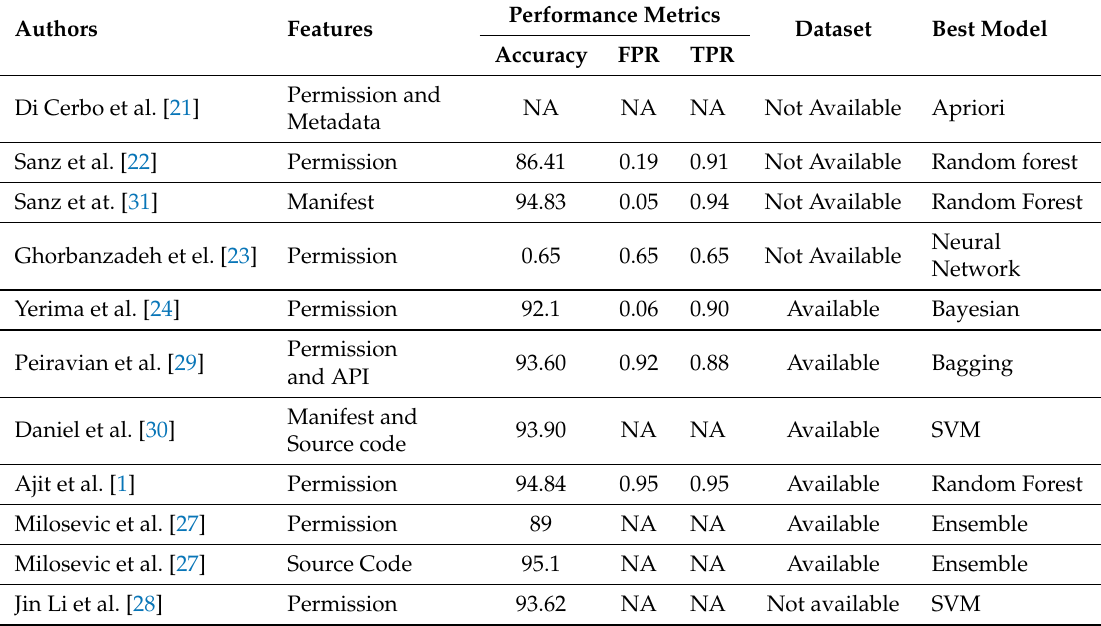
Table 2. Android Malware Detection Using Static